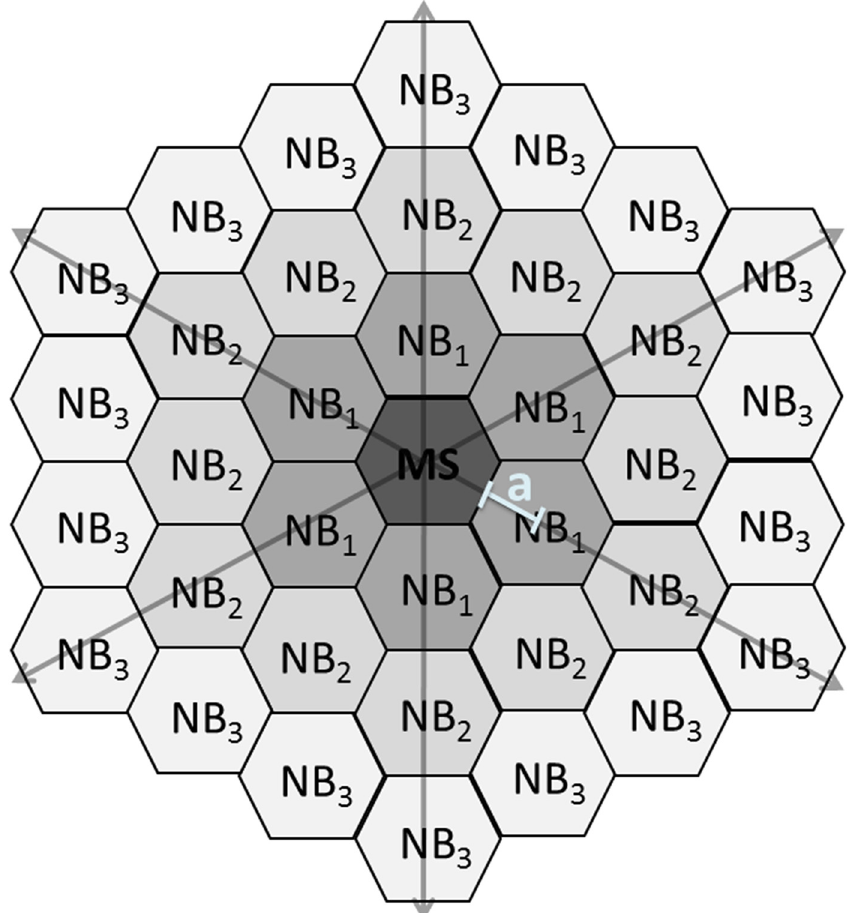
Fig 1. Numbering of the cell layers. Schematic representation of the location of the mechanically stimulated (MS) cell with respect to the neighboring (NB) cell layers: NB 1 is the first layer which is in direct contact with the MS cell; NB 2 is the second layer which is in direct contact with NB 1 , and so forth. White line segment marks an apothem (a) of a